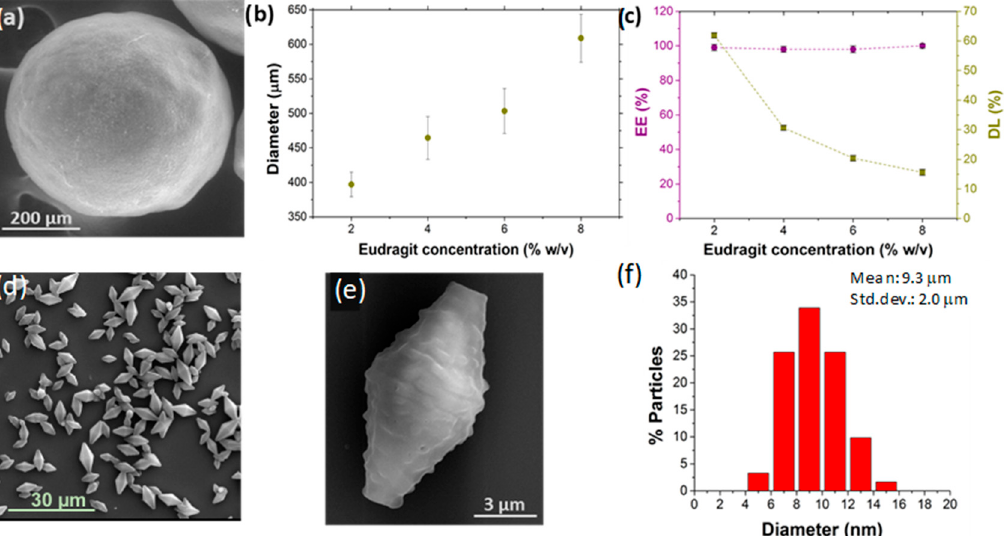
Figure 4. ( a ) SEM image of a Trojan microparticle synthesize with 2% ( w / v ) Eudragit ® using the coaxial microfluidic system. Study of the influence of Eudragit ® concentration on: ( b ) the diameter, ( c ) the encapsulation efficiency (EE) and drug loading (DL) of the enteric microparticles synthesized in the microfluidic system. ( d , e ) SEM images and ( f ) size distribution of the Trojan microparticles obtained in batch conditions with 2% ( w / v ) Eudragit ® .